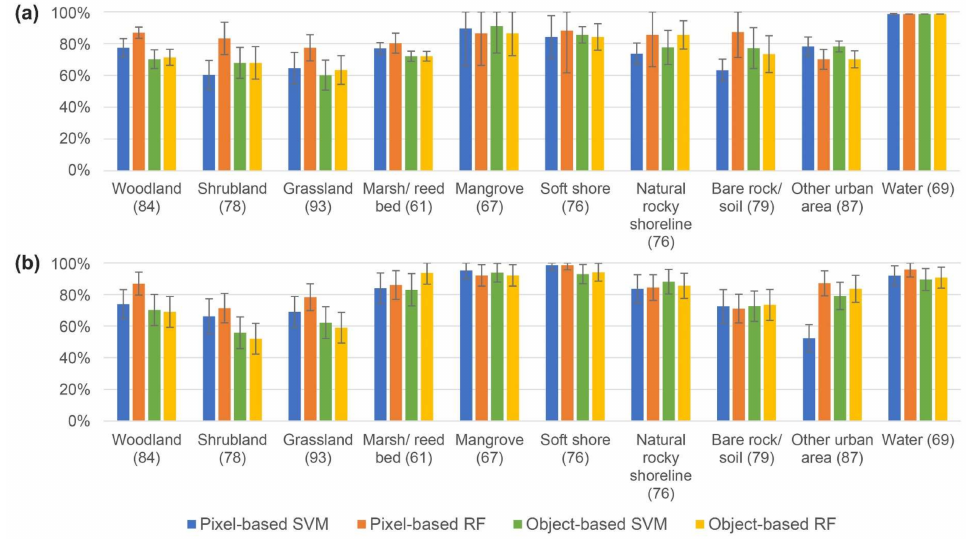
Figure 7. Comparison of ( a ) producer’s accuracies and ( b ) user’s accuracies of individual class using the four classification methods obtained in stage 2. The error bars indicate the 95% confidence intervals of the accuracy measures. The numbers inside the parentheses indicate the numbers of assessment